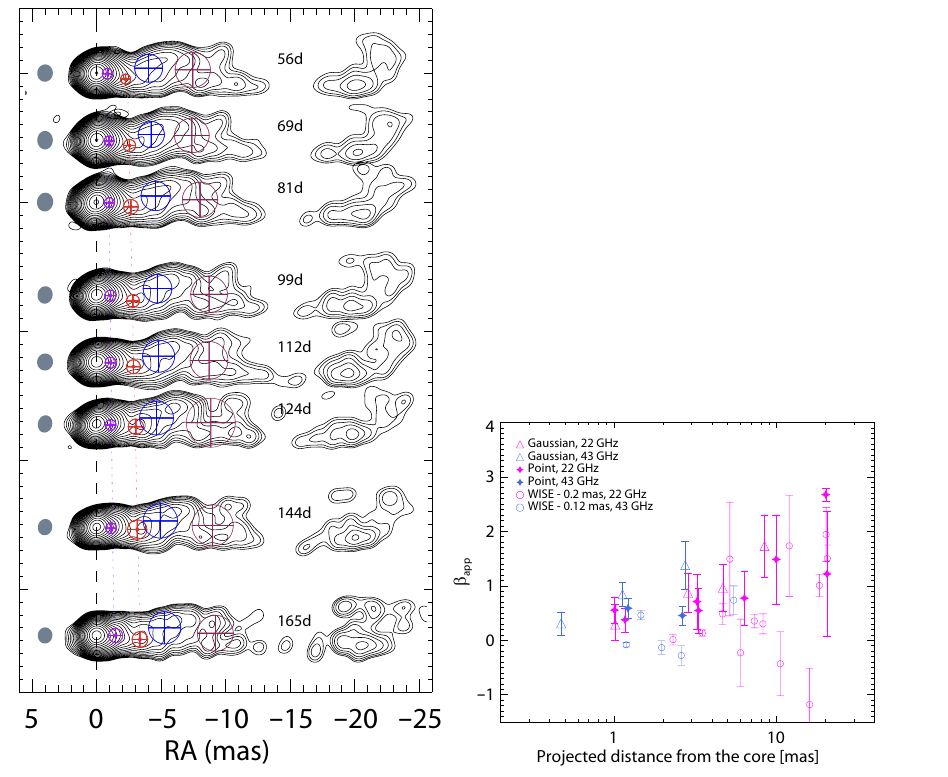
Figure 4. ( Left ) CLEAN images of M87 obtained with KaVA at 22 GHz. The images are obtained at eight epochs from 2016 February 26 to June 15. Circular Gaussian components obtained by the modelfit analysis are overlaid on the images. ( Right ) Apparent jet speed as a function of projected distance from the core of M87. Symbols shown with magenta and blue colors represent the data obtained at 22 and 43 GHz, respectively. Adapted from the work in [83] with permission from the American Astronomical Society